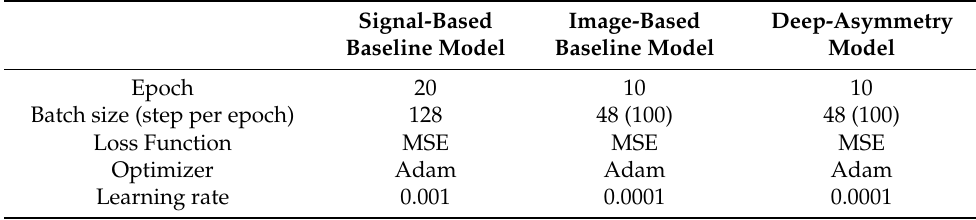
Table 4. The hyperparameters of model training.